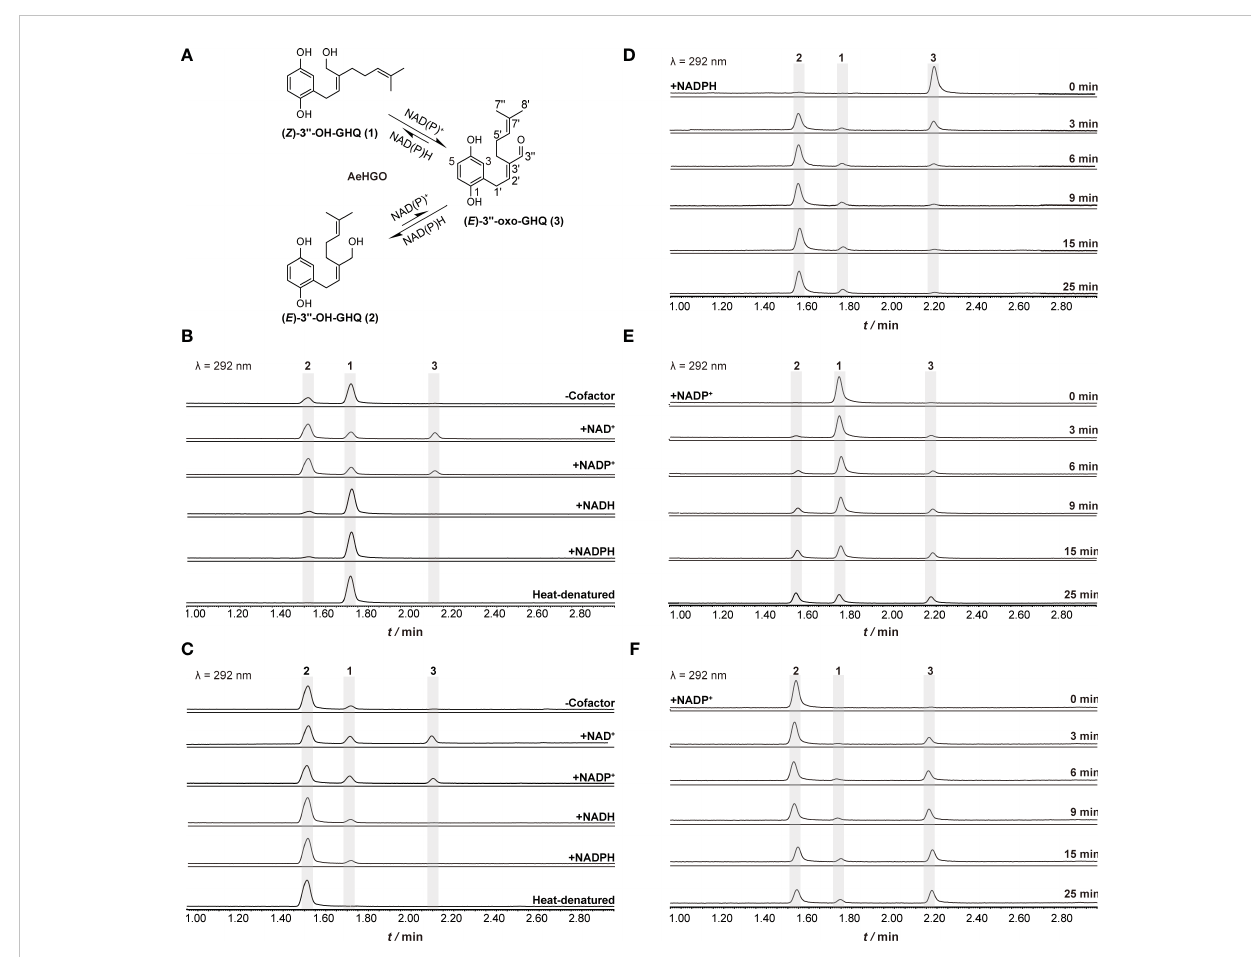
FIGURE 4 Functional characterization of recombinant AeHGO and time-course analysis of the enzymatic reactions. The detection wavelength is set at 292 nm. The reaction mixture containing heat-denatured AeHGO is used as a control. (A) Process of the reaction catalyzed by recombinant AeHGO. The chemical structures of the compounds and corresponding peaks in UPLC chromatogram are marked as 1 – 3. The length of an arrow represents relative reaction velocity. (B) Chromatograms showing reactions containing ( Z )-3 ’’ -OH-GHQ (1) with AeHGO protein in the presence or absence of cofactors. (C) Chromatograms showing reactions containing ( E )-3 ’’ -OH-GHQ (2) with AeHGO protein in the presence or absence of cofactors. (D) Chromatograms showing reactions using ( E )-3 ’’ -oxo-GHQ (3) as the substrate with NADPH for 0 – 25 min. (E) Chromatograms showing reactions using ( Z )-3 ’’ -OH-GHQ (1) as the substrate with NADP + for 0 – 25 min. (F) Chromatograms showing reactions using ( E )-3 ’’ -OH-GHQ (2) as the substrate with NADP + for 0 – 25